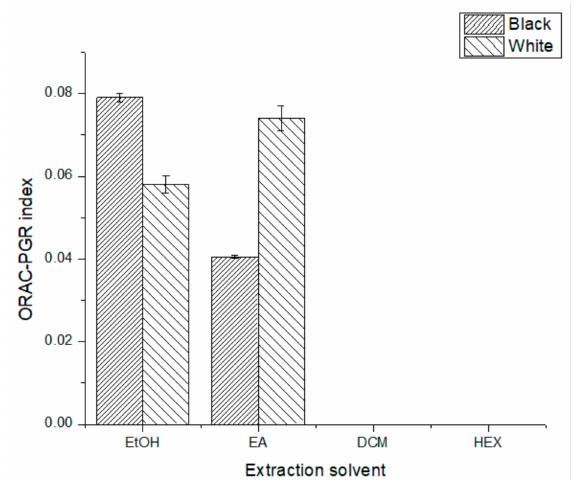
Figure 2. ORAC-PGR index for all extracts tested. All differences were statically significant ( p < 0.05). ORAC assays are described as a Hydrogen Atom Transfer methodology, while DPPH inhibition in a methanolic medium is that of an Electron Transfer [23]. DPPH is a relatively stable radical with an absorbance maximum at 517 nm. This band disappears in the reduction reaction product enabling the spectrophotometric AC determination [23]. Again, the AC measurement for all extracts was possible (Figure 3), the ethanolic extracts being those with the highest %Inhibition for both seed phenotypes with B-EtOH, having a %Inhibition of 61 ± 5% and W-EtOH of 52 ± 3%. DPPH data indicate a significant difference between all samples ( p < 0.05) and, as well as ORAC results, the ethanolic extracts were those with the highest AC for both